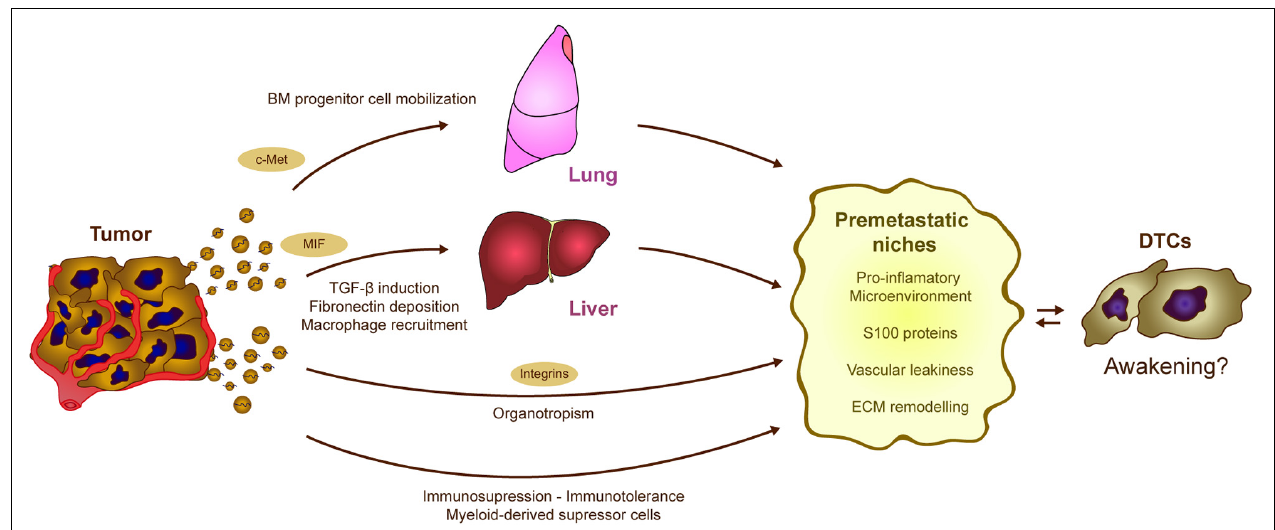
FIGURE 4 | Potential contribution of tumor-EVs to DTC awakening. The processes regulated by tumor derived EVs in formation of PMNs could be involved in DTC awakening. Tumor exosomes induce the mobilization of bone marrow precursors, which eventually contribute to the generation of pro-inflammatory and immunosuppressive niches. Similarly, alterations in the stromal cells of the liver result in the generation of a fibrotic and pro-tumorigenic microenvironment. Moreover, both PMN and sleepy niches are organotropic processes that occur at specific locations along the body depending on the tumor type. Interestingly, the expression of different integrins on the EVs surface seems to mediate metastatic organotropism. Overall, tumor derived exosomes trigger different processes as the induction of pro-inflammatory microenvironments, vascular modification, and EMC remodeling which result into the generation of optimal pre-metastatic niches. These processes may affect the equilibrium between dormancy and awakening in the